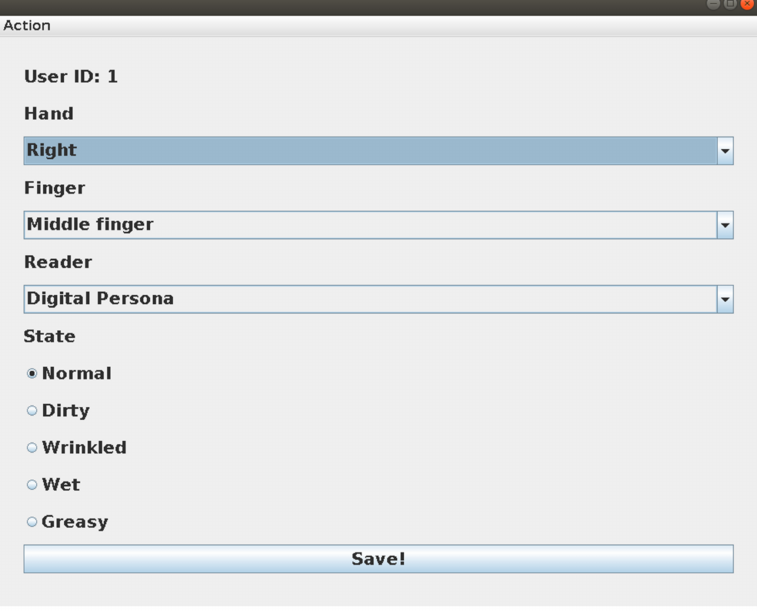
Figure 5. Fingerprints collection application